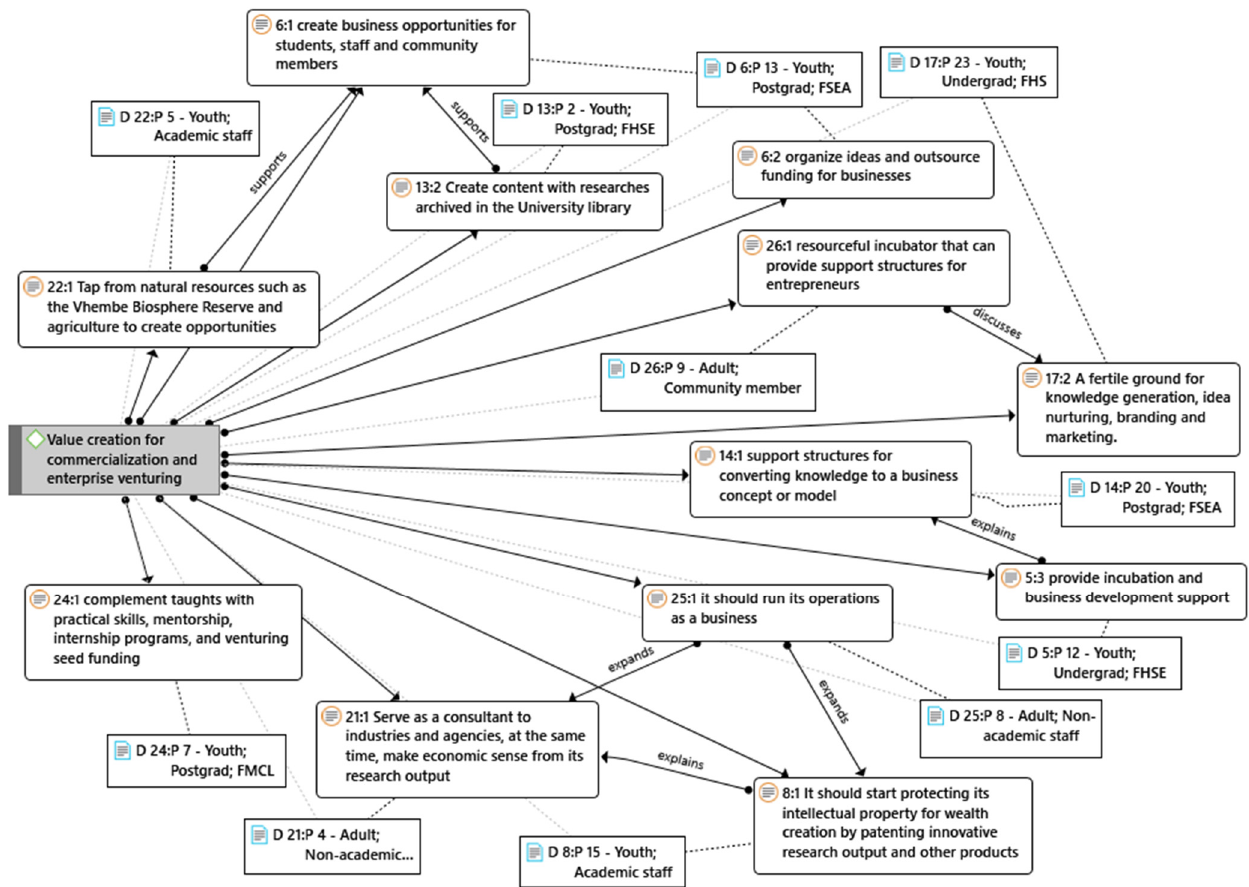
Figure 4. Value creation for commercialization and venturing.